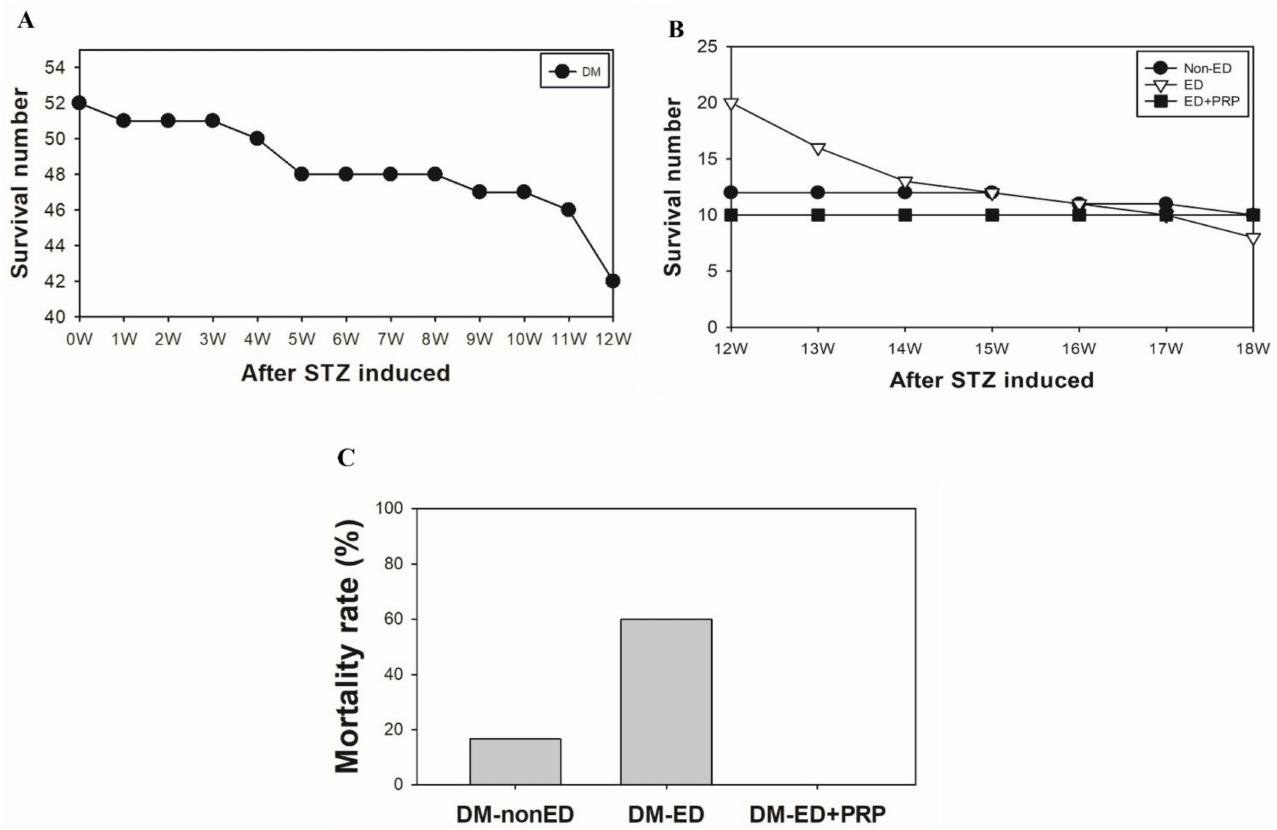
Figure 2. The graphical representation of the decreased mortality rate due to platelet-rich plasma (PRP) treatment. ( A ) Indicating mortality rate of rats after streptozotocin (STZ) induction until 12 weeks. ( B ) Showing the survival rate of the rats after the first ICP measurement and follow- up experiments. ( C ) Histogram showing the comparison among rats belonging to DM-non-ED, DM + ED, and DM + ED + PRP treatment. DM-ED, STZ-induced diabetes mellitus (DM) with erectile dysfunction (ED) and treated with saline ( n = 20); DM-ED + PRP, STZ-induced DM with ED and treated with PRP ( n = 10); vehicle-treated n =